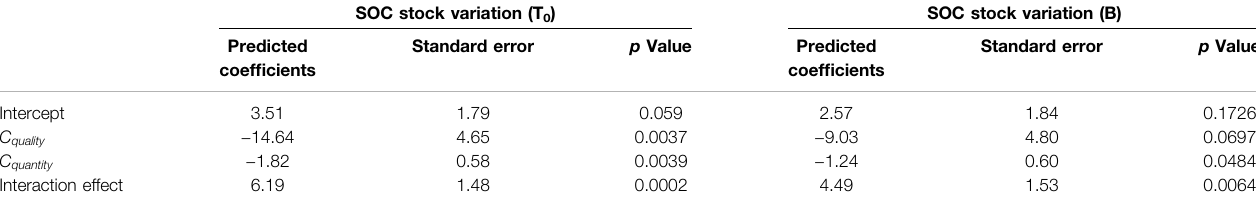
TABLE 6 | Results of the linear mixed effect model of Eq. 3 .